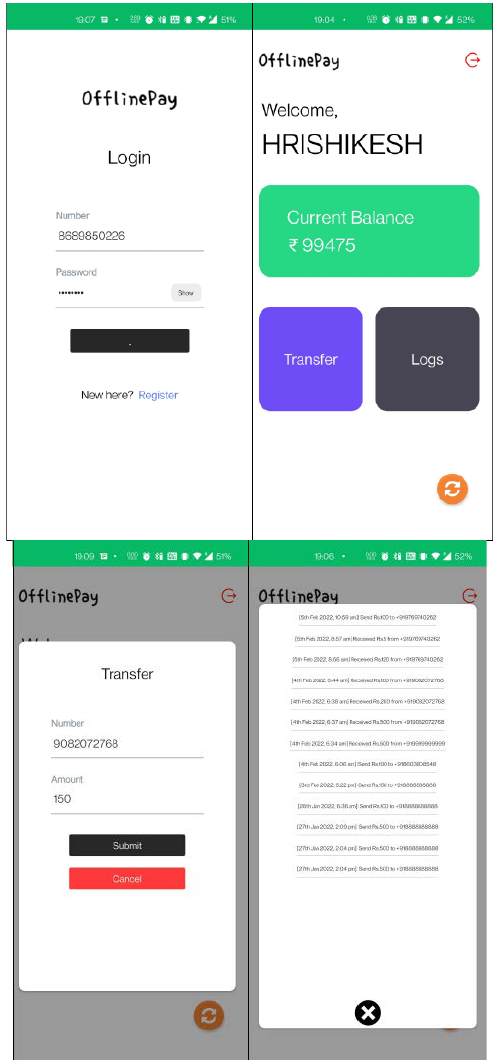
Figure 3: Login and subsequent pages